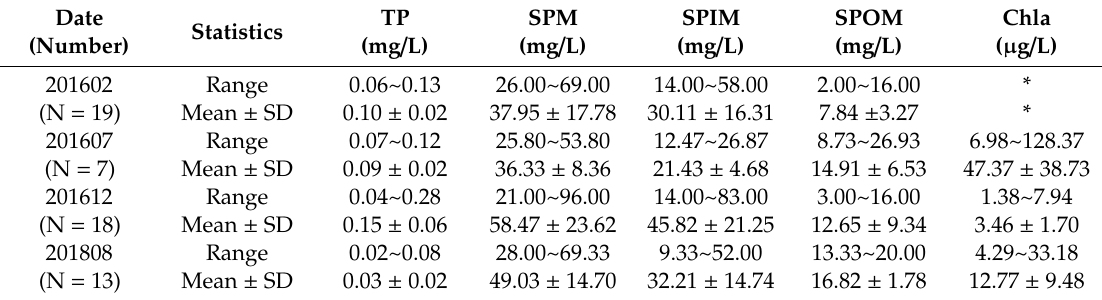
Table 1. Water properties of Lake Hongze.